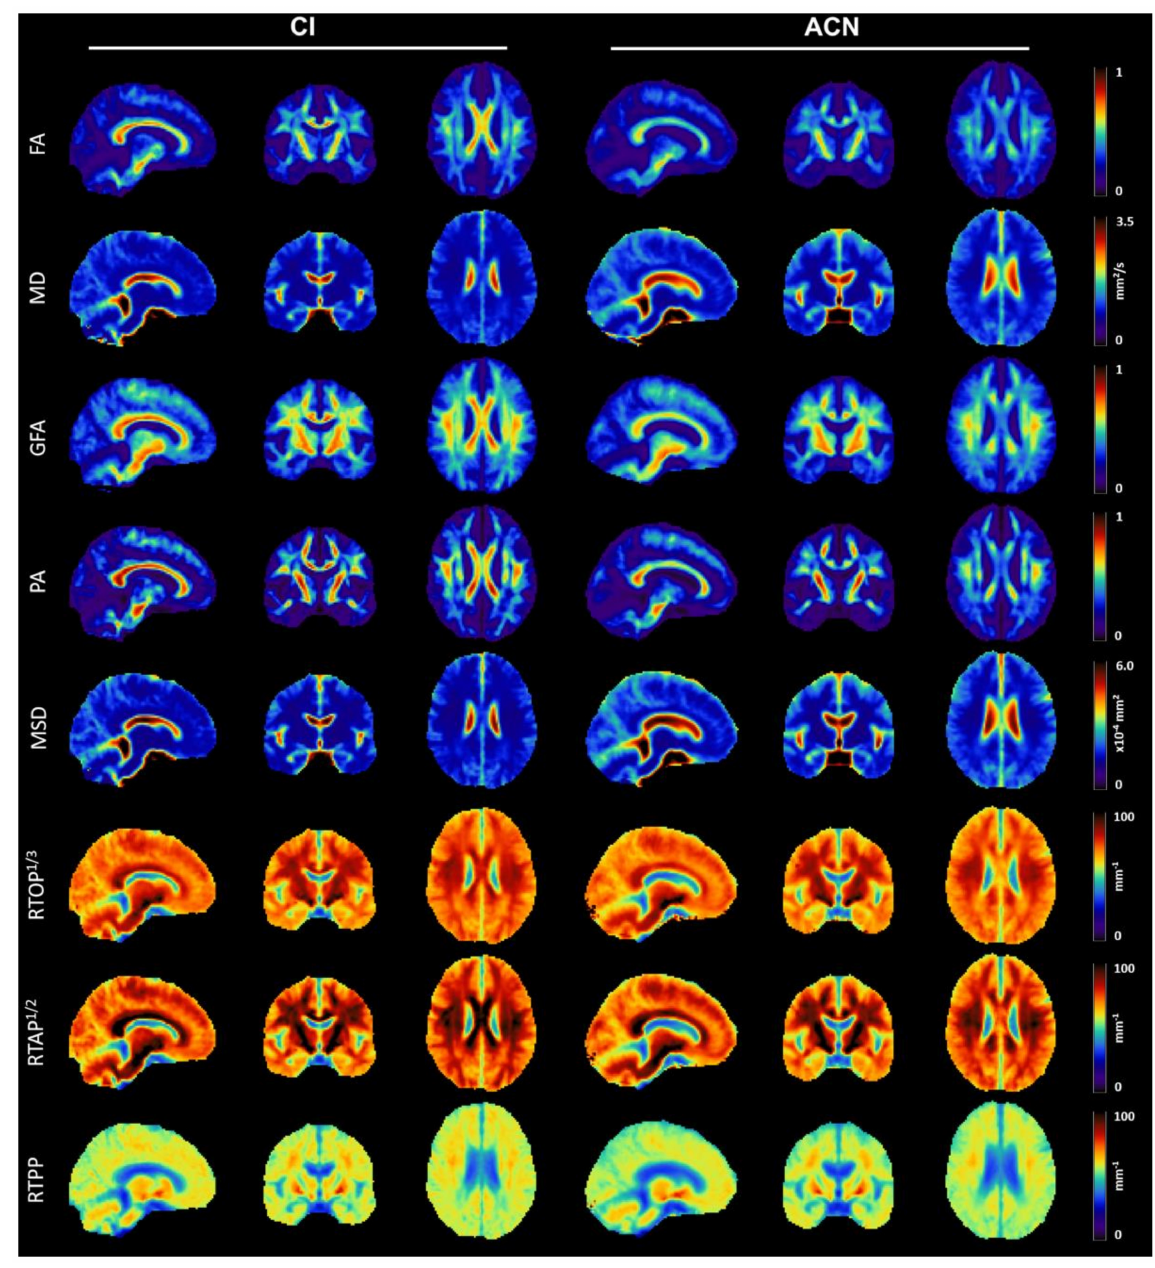
Figure 1. Microstructural maps of values averaged across cognitive impaired (CI) and apparently cognitive normal (ACN) patients, respectively. The representative sections reported here are in MNI space and are displayed in radiological convention. FA = fractional anisotropy; MD = mean diffusivity; GFA = generalized fractional anisotropy; PA = propagator anisotropy; MSD = mean square displacement; RTOP = return to the origin probability; RTAP = return to the axis probability; RTPP = return to the plane